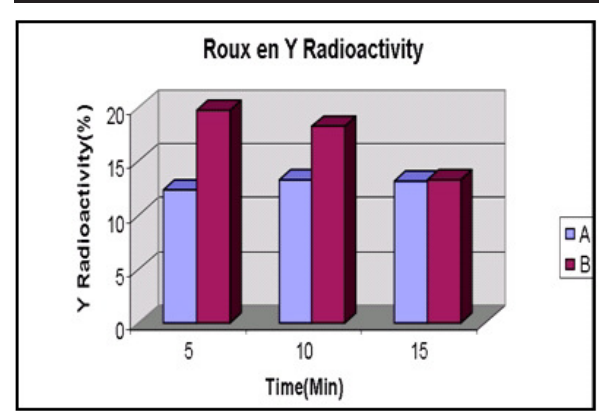
FIGURE 2 - Radioactivity emitted by the Roux limb, at 5, 10 and 15 minutes expressed as a percentage of the total radioactivity emitted by the digestive tract in the groups studied after introduction of Technetium 99m phytate into the stomach through an orogastric catheter.